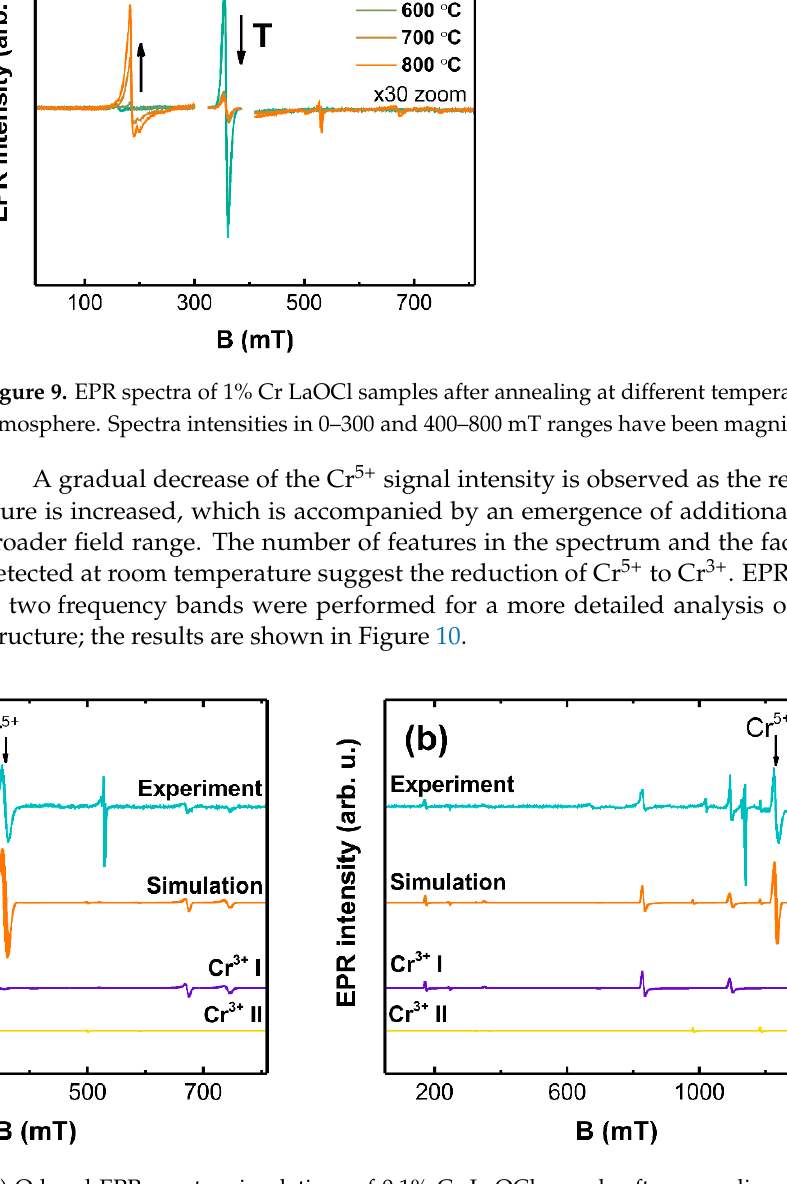
Figure 8. ( a ) A structural model of the lanthanum ion substitution by chromium (left). Calculated Cr K ‐ edge XANES spectra for different positions of chromium atoms displaced along the c ‐ axis by Δ z relative to the lanthanum position (right). ( b ) A fragment of the structural model of the chromium environment with the tetrahedral coordination by chlorine atoms (left). The calculated Cr K ‐ edge XANES spectrum (right). The pre ‐ edge peak is indicated by arrows. X ‐ band EPR spectra of 1% Cr samples annealed at different temperatures in the H 2 /Ar atmosphere are shown in Figure 9.